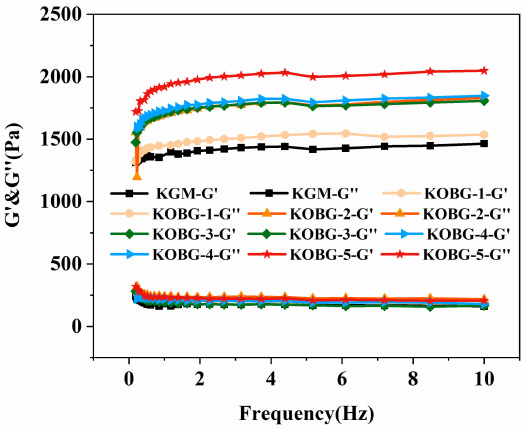
Figure 2. Frequency sweep results of KGM gel and composite hydrogel.